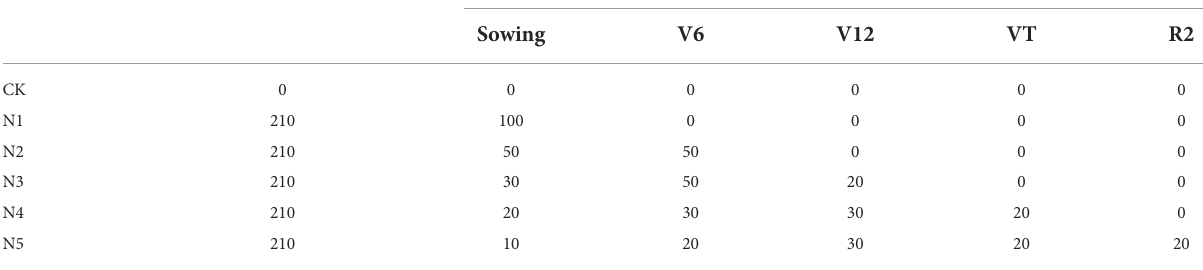
TABLE 1 Proportion of total nitrogen (N) fertilizer and growth stage in which fertilizer was applied in different N treatments in fi lm-mulched drip- irrigated maize in Northeast China. Treatment N rate (kg ha − 1 ) Proportion (%) applied per growth stage